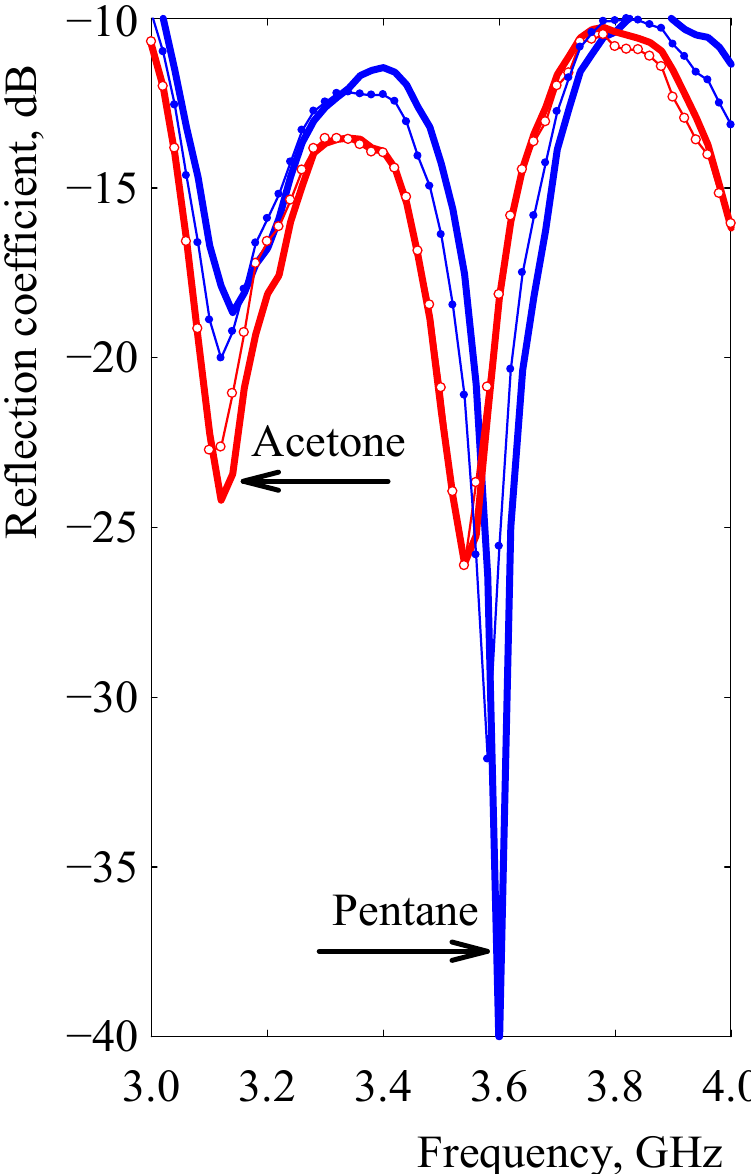
Figure 12. The frequency dependence of the reflection coefficient after the 120 s exposure to binary vapor mixture of polar acetone and non-polar pentane. The frequency spectrum of acetone and pentane is represented by thick red and blue lines, respectively. Filled and open circles denote acetone/pentane mixtures in the volume ratio 25:75 and 75:25, respectively.